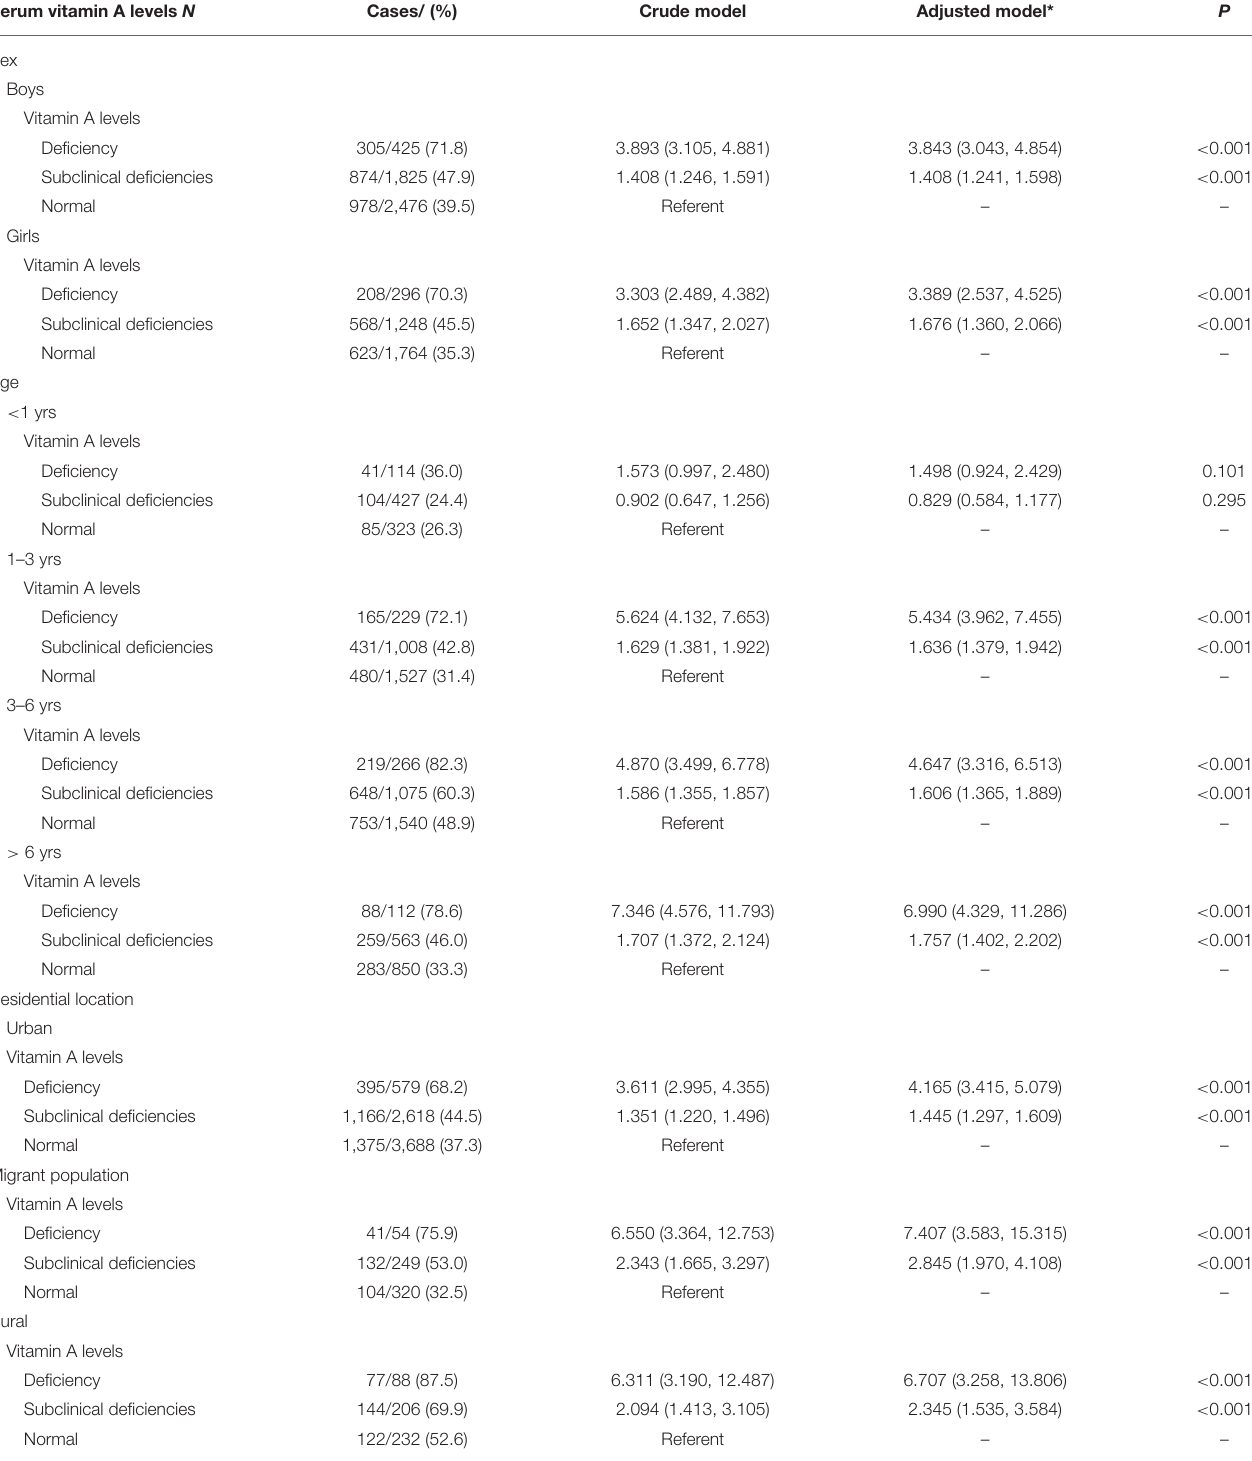
TABLE 3 | Associations between serum vitamin A levels and risk of respiratory infections in subgroups. Serum vitamin A levels